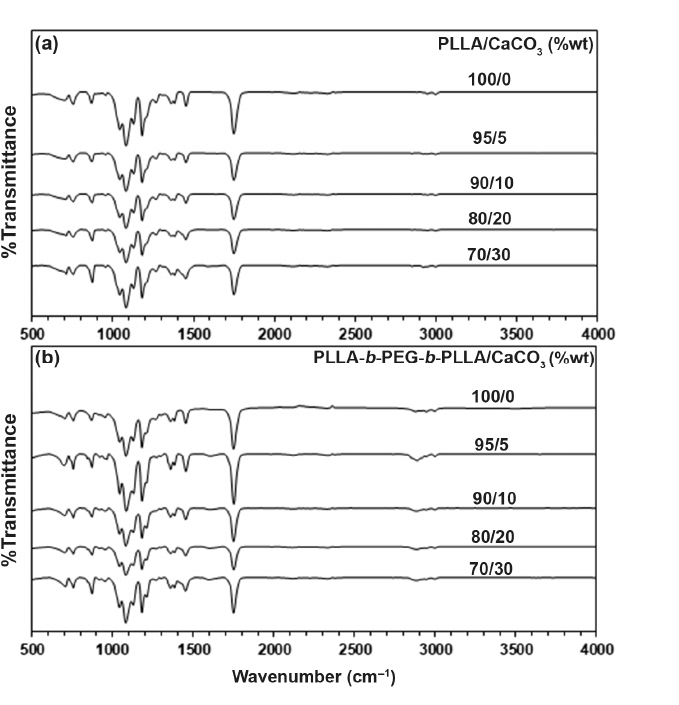
Figure 2. ATR-FTIR spectra of ( a ) PLLA/CaCO 3 and ( b ) PLLA- b -PEG- b -PLLA/CaCO 3 composite films with various CaCO 3 ratios.